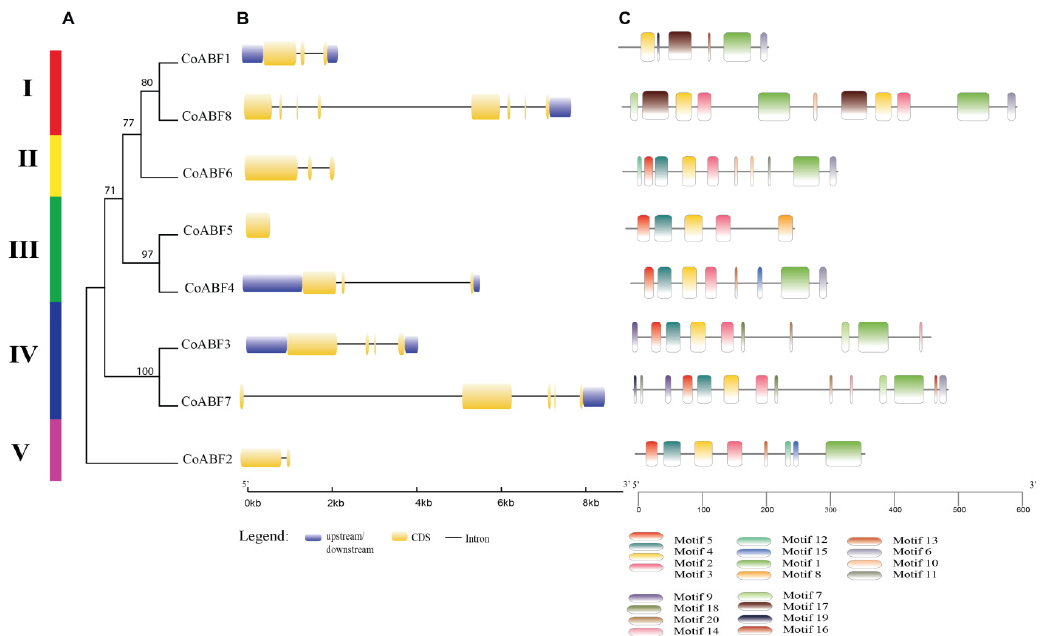
Figure 2. Gene structure and conserved motifs of CoABF genes were analyzed. ( A ) A phylogenetic tree was constructed with 1000 bootstraps, using the neighbor-joining method. ( B ) Gene structure was analyzed by Gene Structure Display Server (GSDS 2.0). The untranslated 5 ′ - and 3 ′ - up- stream/downstream regions, exons, and introns are represented by blue and yellow boxes and black lines, respectively. ( C ) The conserved motifs were analyzed by the MEME suite web and are dis- played in different colors.